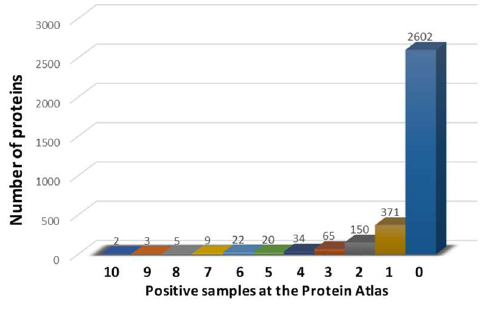
Figure 1. Number of proteins expressed in liver tumor samples, divided by the number of positive samples with high level of expression.